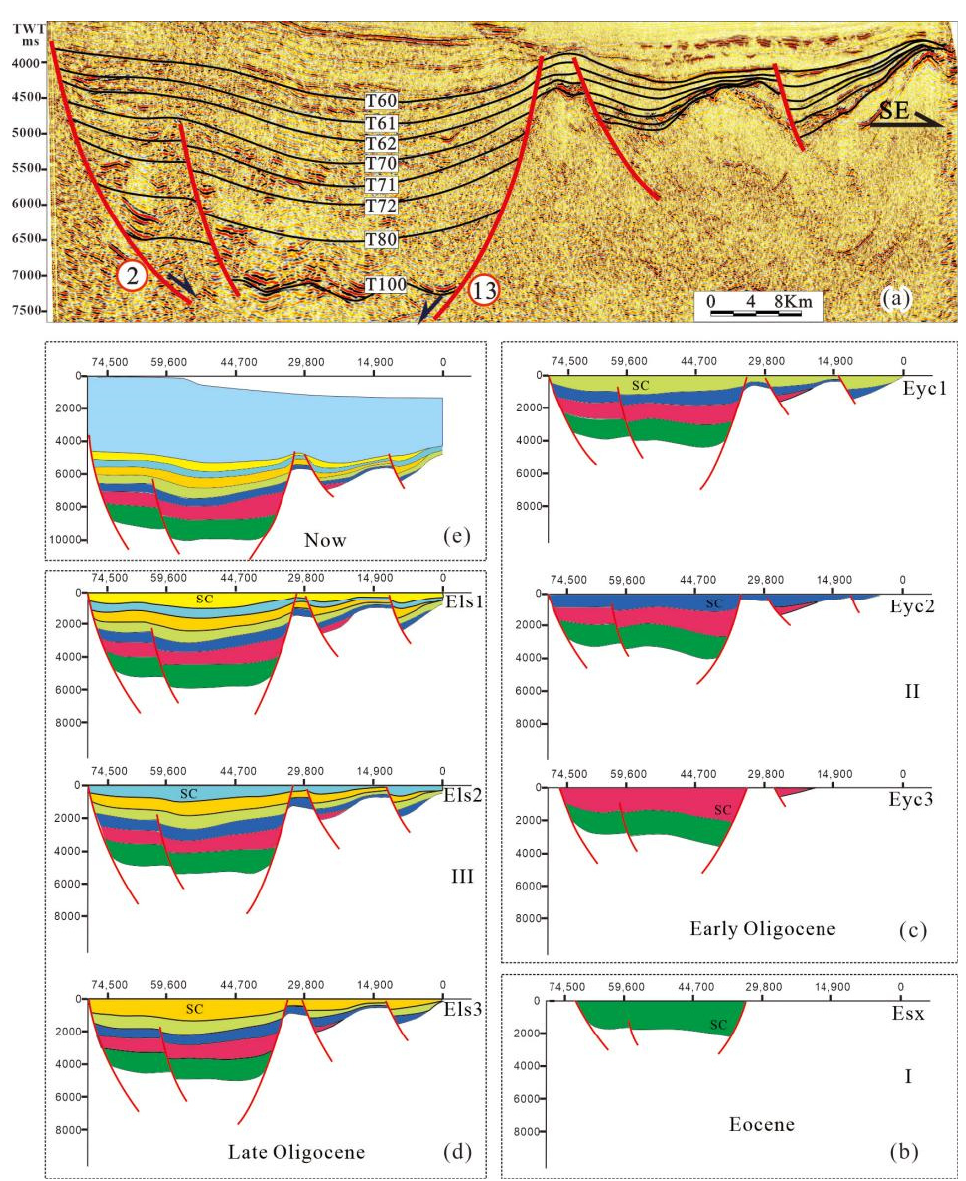
Figure 6. Two-dimensional backstripping and subsidence evolution of the seismic profile C located in the study area. ( a ) The sequence framework of the seismic profile C; ( b ) The backstripping section in Phase-I; ( c ) The backstripping section in Phase-II; ( d ) The backstripping section in Phase-III; ( e ) The section currently. (SC: subsidence center; see Figure 1 for the location of the seismic profile.)